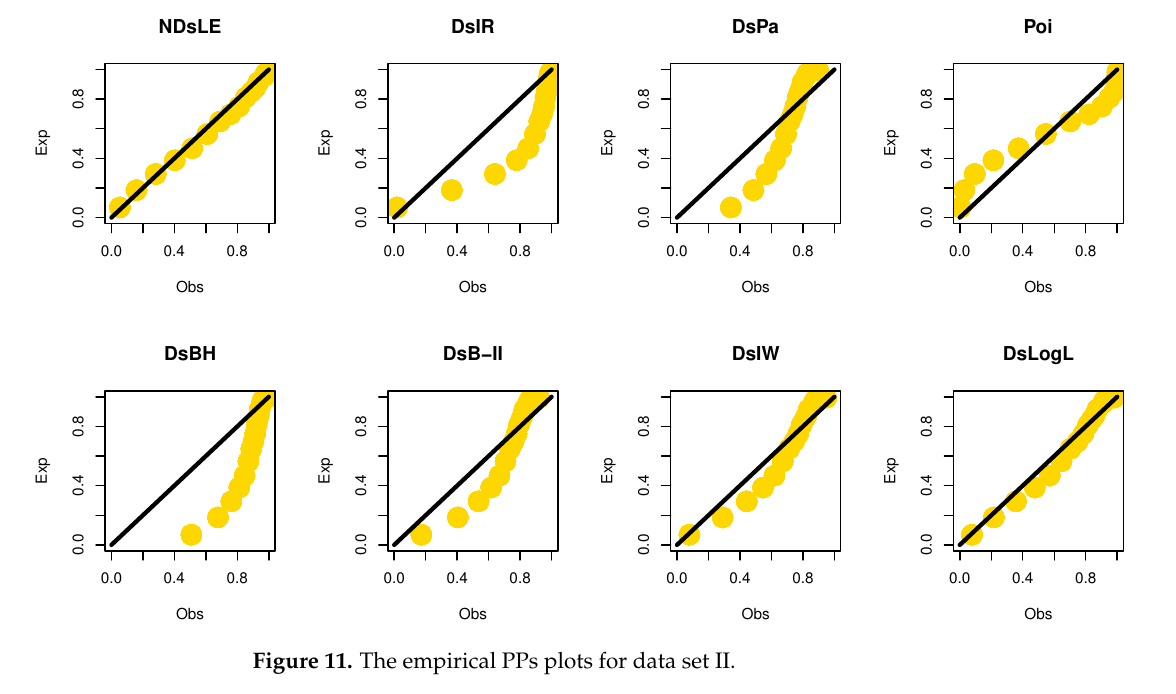
Figure 11. The empirical PPs plots for data set II. Table 10. CVE for data set II.